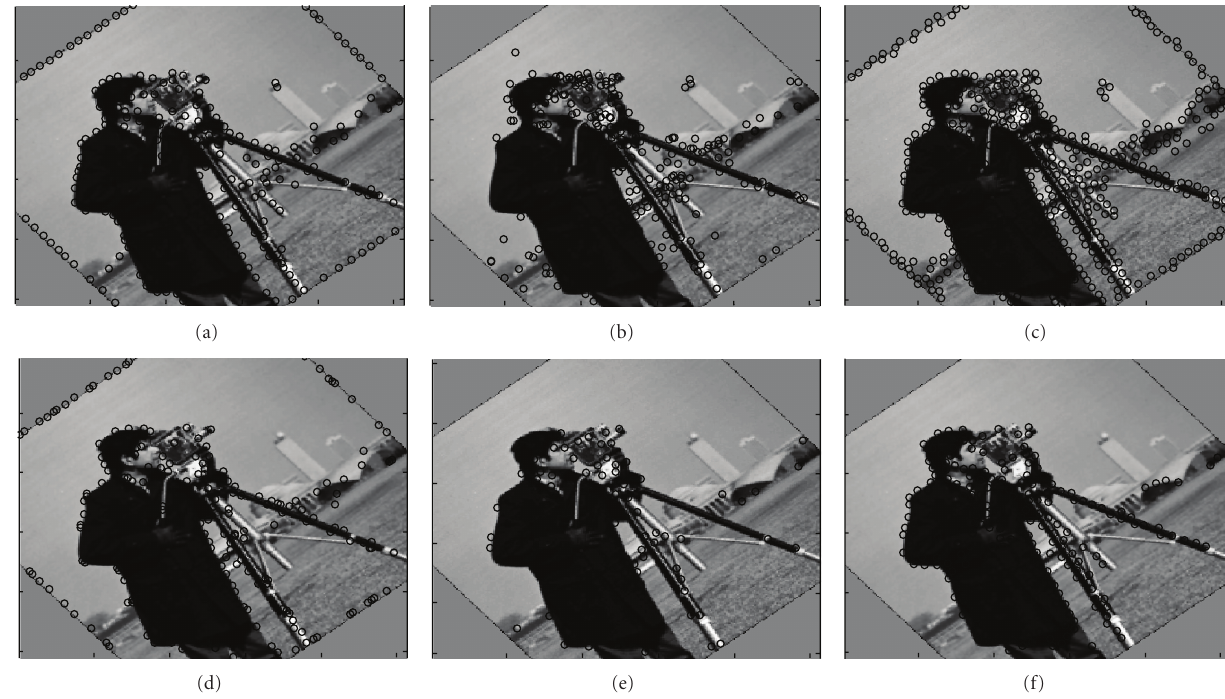
Figure 5: Feature points detected in 40 ◦ rotated image by (a) Harris’ method, (b) Lowe’s method, (c) Tomasi’s method, (d) Loupias’ technique, (e) Yeh’s algorithm, and (f) proposed